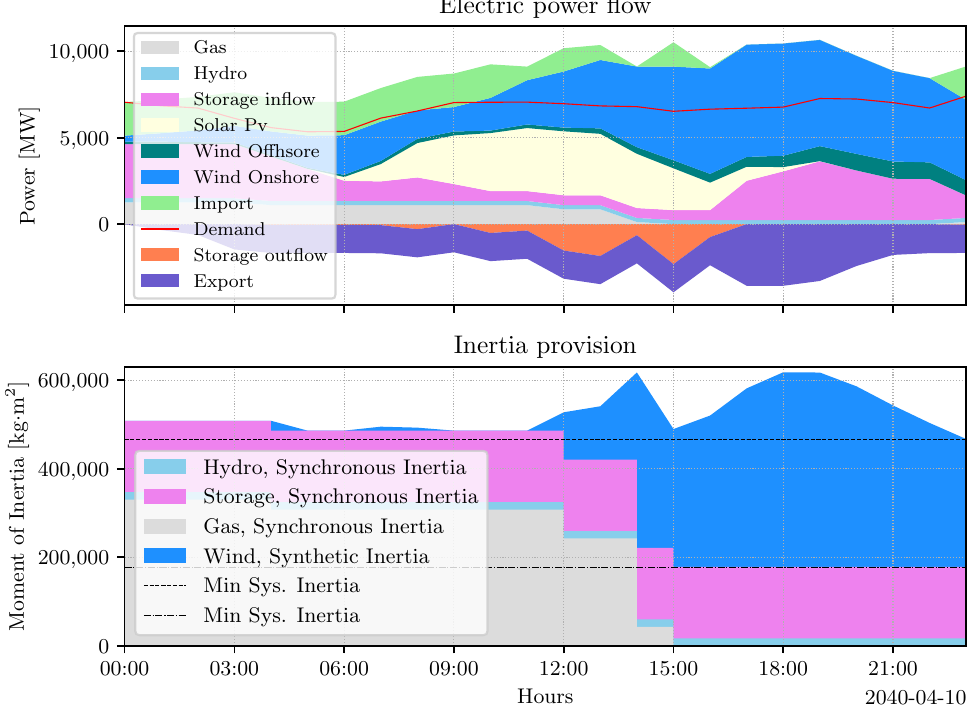
Figure 4. Illustration of a 24 h time series of the parameter combination: ROCOF threshold = 2 Hz/s and demanded inertia constant = 3.5 s. The top subplot depicts electric power flow results and the bottom subplot flow provided